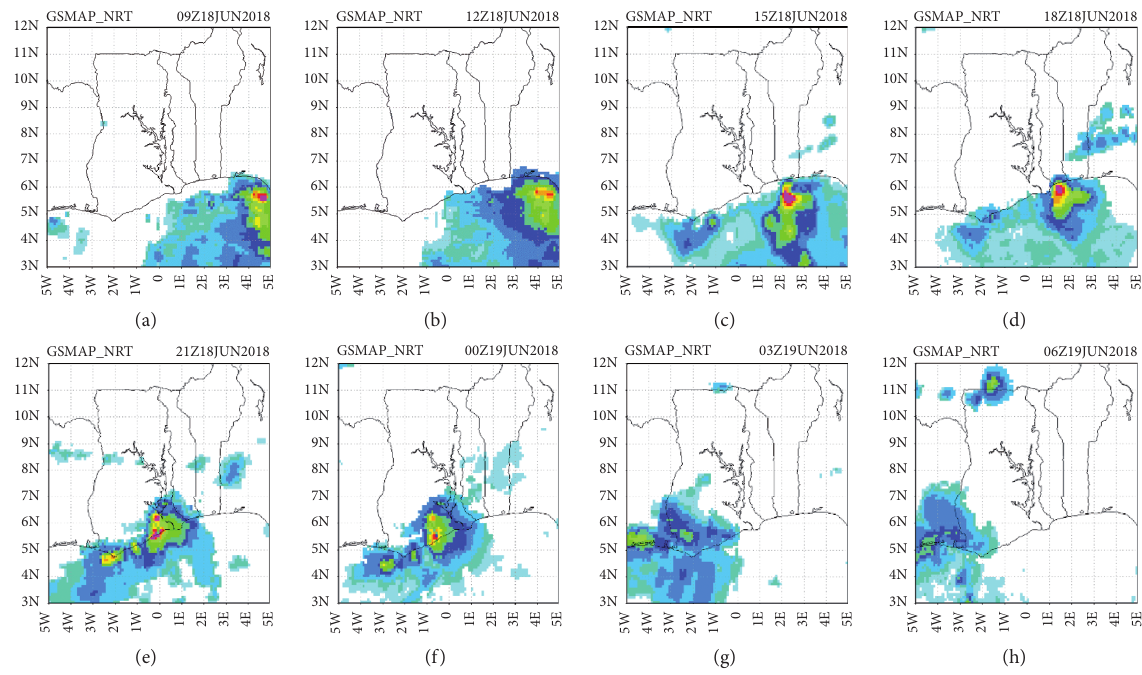
Figure 2: GSMaP satellite products. Three hourly precipitation intervals from 09 UTC of the 18th of June to 06 UTC of the 19 th of June 2018 for case A.